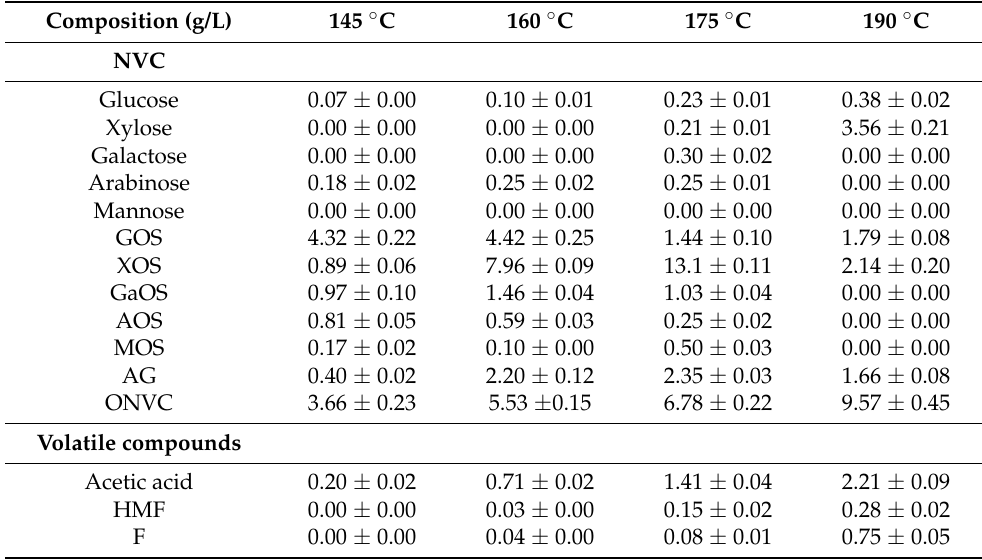
Table 1. Effects of fractionation treatments on the concentrations of the reaction products. Composition